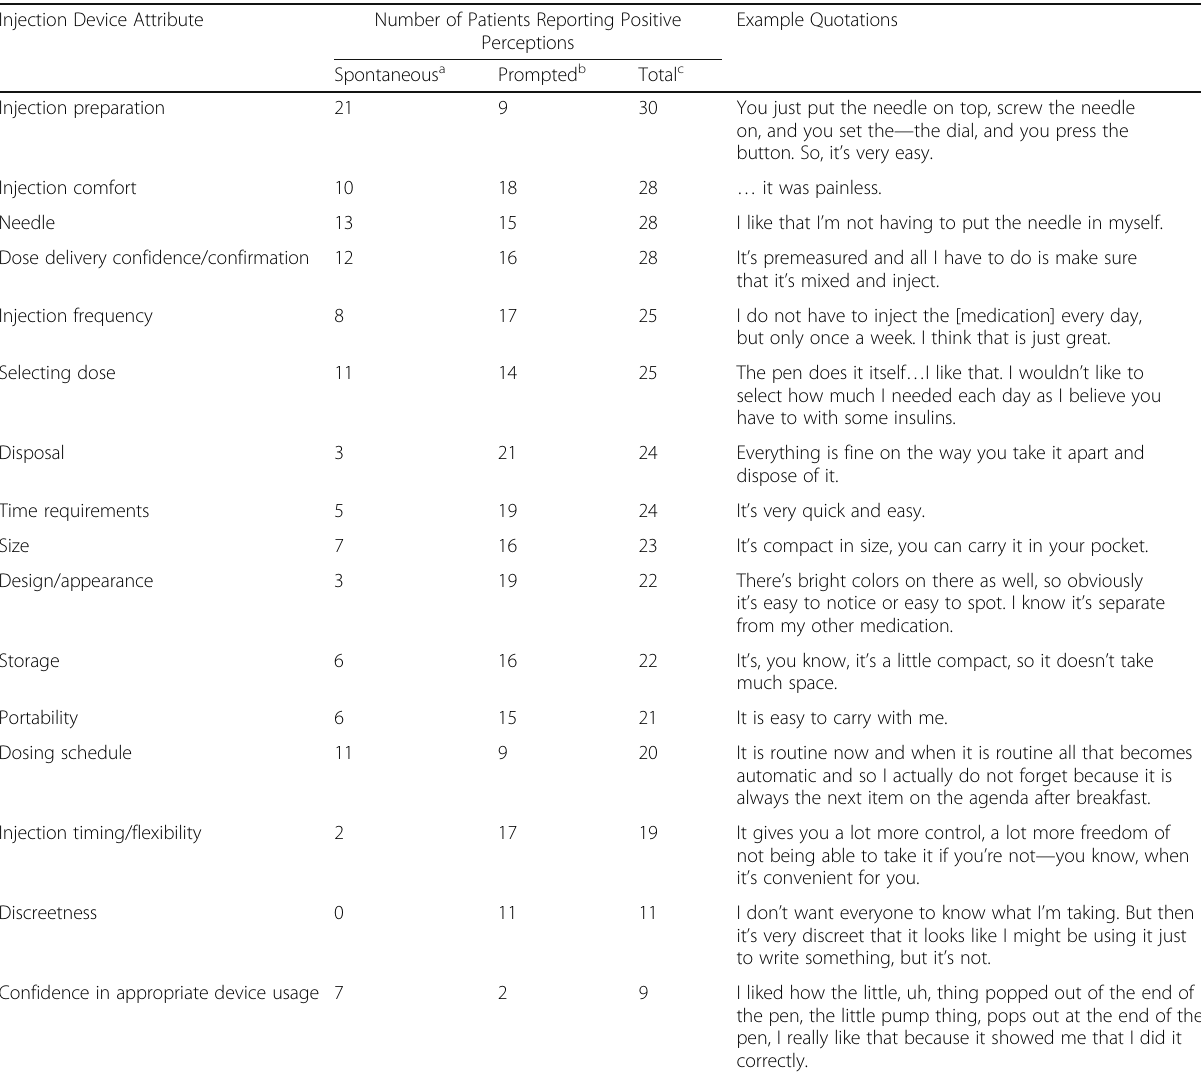
Table 2 Positive Perceptions of Injection Device Attributes ( N = 32) Injection Device